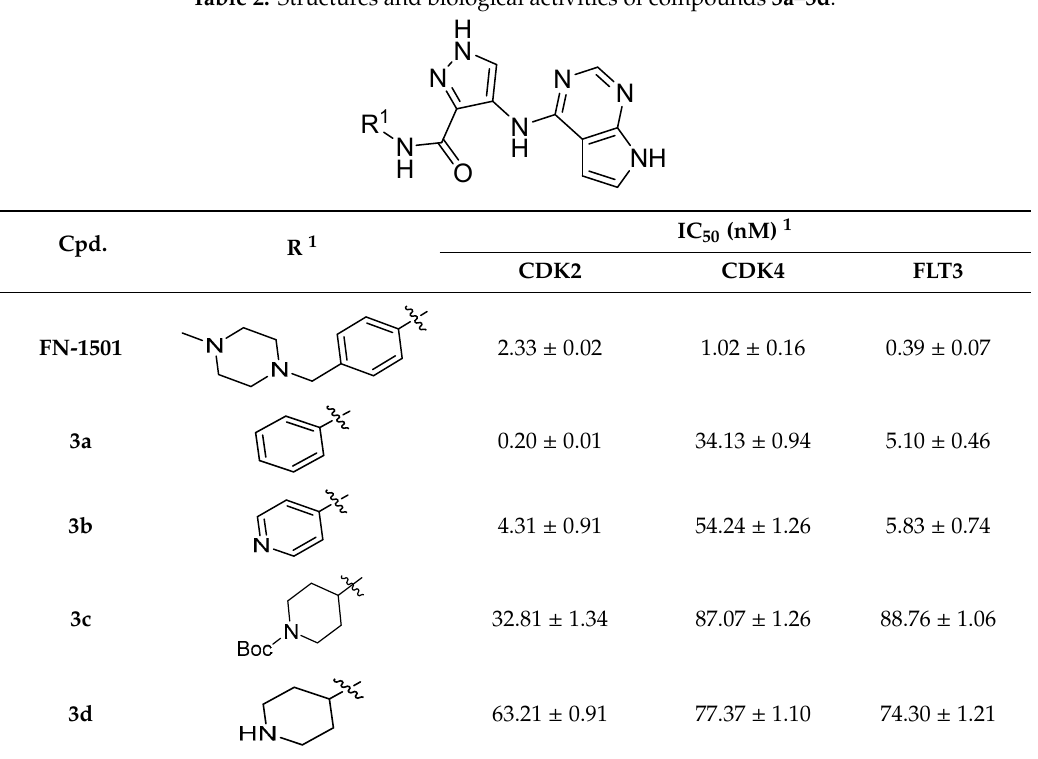
Table 2. Structures and biological activities of compounds 3a – 3d.